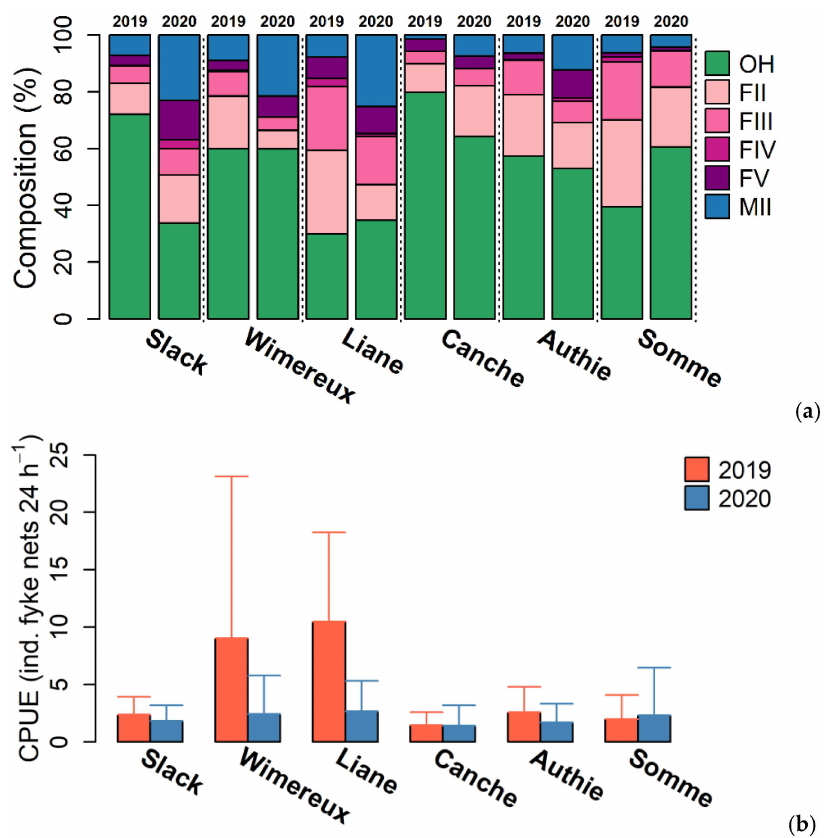
Figure 2. Variation of ( a ) the percentage of individuals per silvering stage (OH undifferentiated growth phase, FII female growth phase, FIII female pre-migration phase, FIV and FV female migration phases and MII male migration phase) and ( b ) means ± standard deviations in CPUE (ind. fyke nets 24 h − 1 ) of the eels in the six estuaries during 2019 and